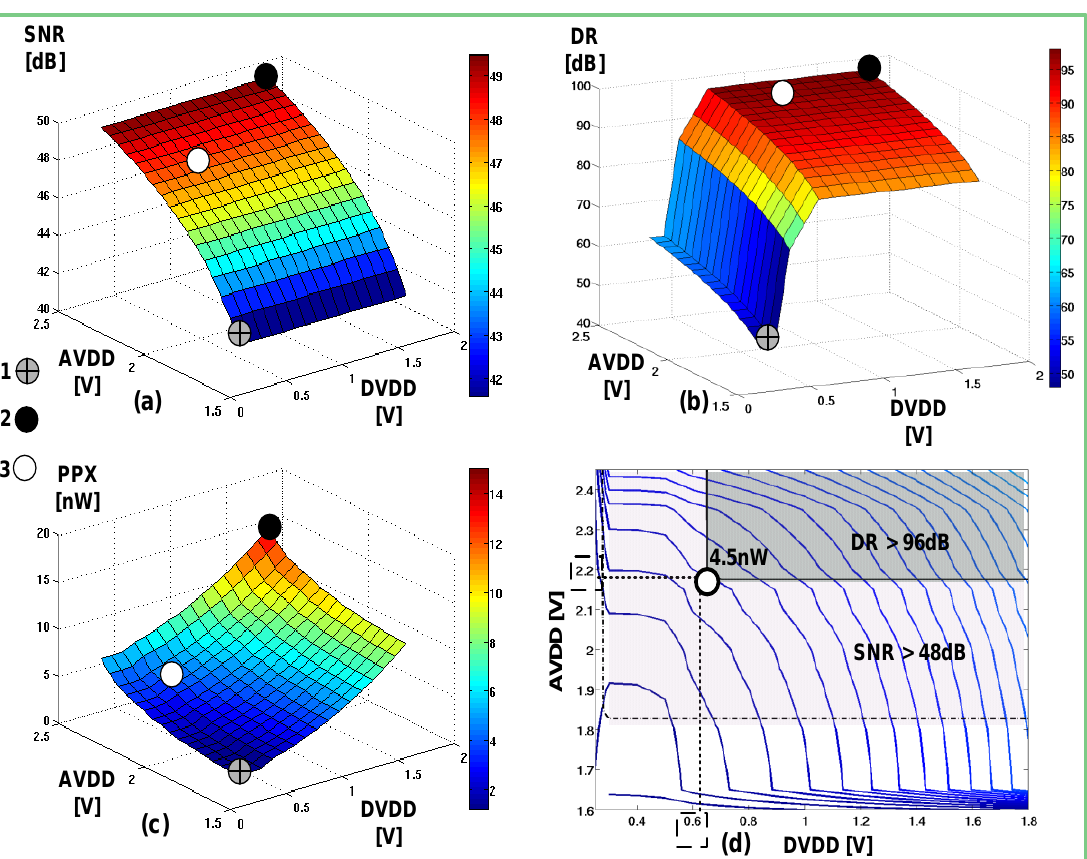
Figure 7. ( a ) SNR vs . AVDD vs . DVDD; ( b ) DR vs . AVDD vs . DVDD; ( c ) PPX vs . AVDD vs . DVDD; ( d ) Contour